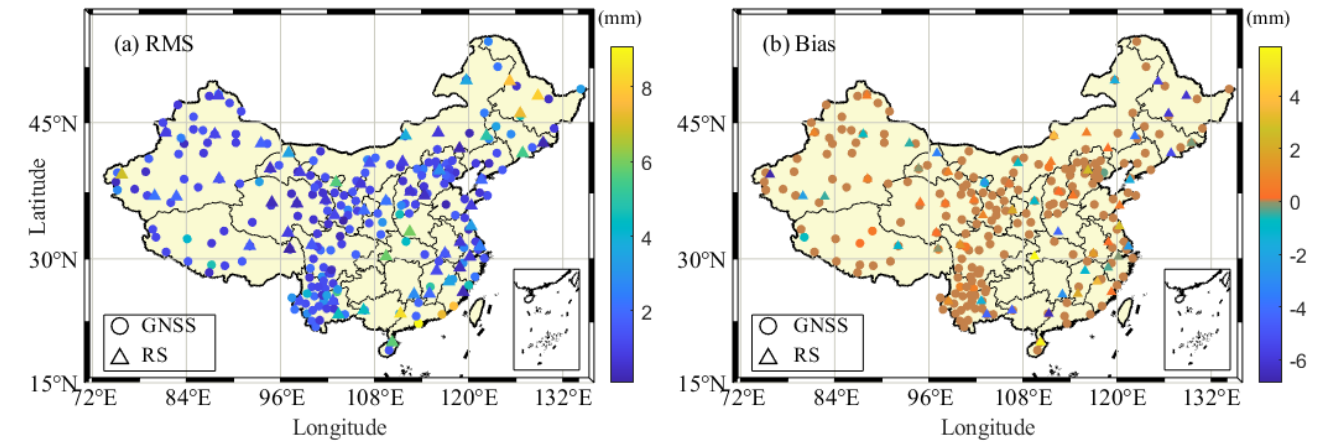
Figure 9. RMS and Bias distributions of PWV differences between Sentinel-3A and GNSS/RS over the period of 1 March 2019 to 4 March 2020. Table 5. Statistical results of RMS, Bias, MAE of PWV differences between Sentinel-3A and GNSS (260)/RS (87) over the period from 1 March 2019 to 4 March 2020.